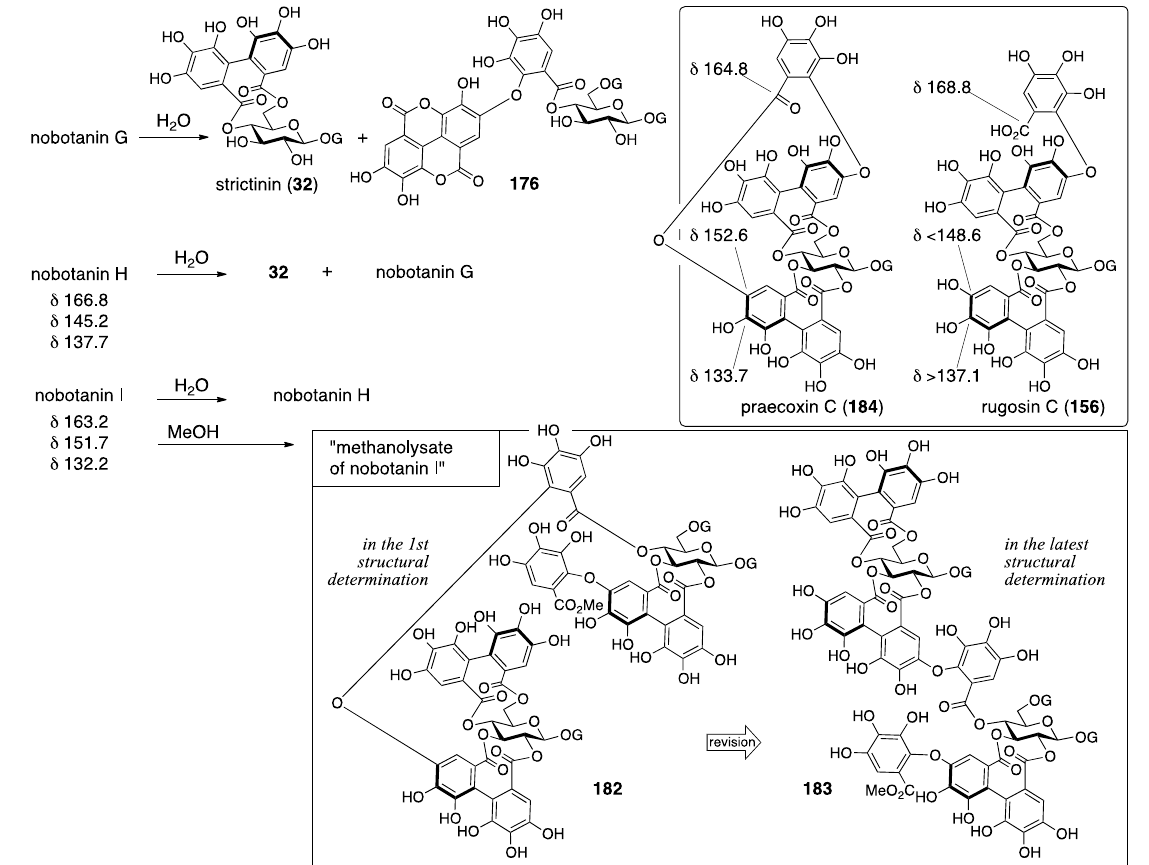
Figure 56. The observations that led to the first structures of nobotanins G, H, and I ( 164 , 166 , and 168 ).